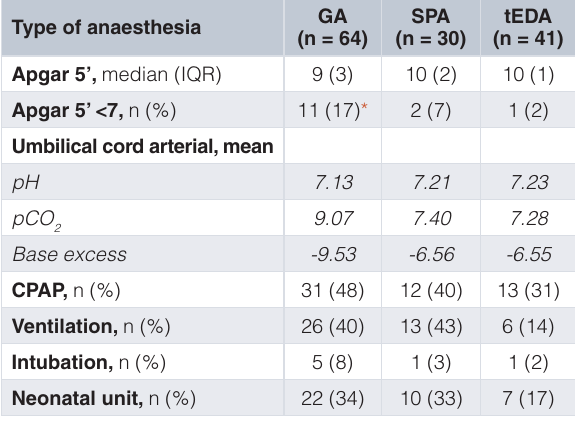
Table 3. Comparison of anaesthetic technique and neonatal outcome. Type of